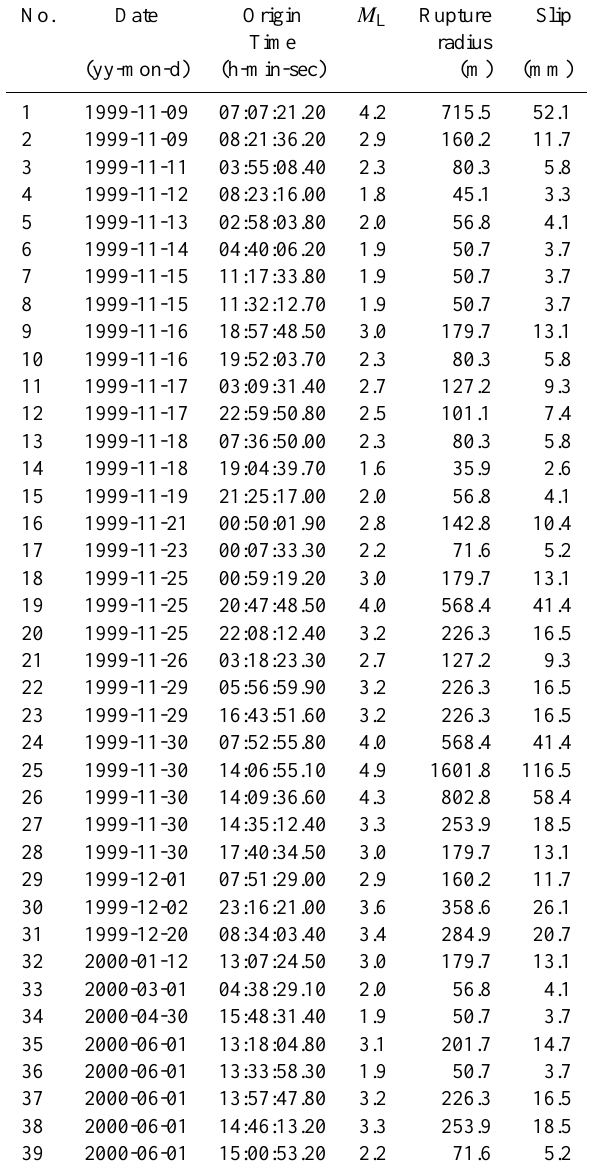
Table A1. Parameters of the Xiuyan